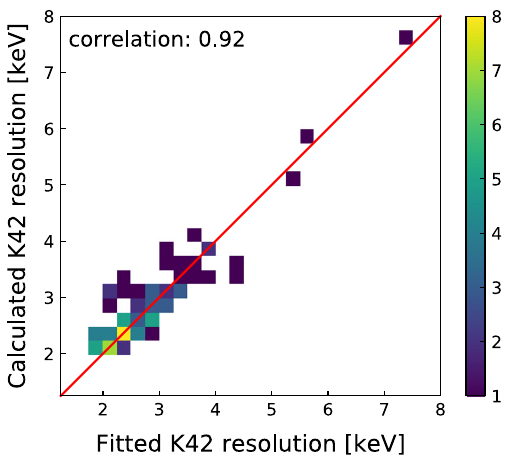
Fig. 7 Resolutionofthe1524.7keV 42 Klineasmeasuredfromphysics data and extracted from calibration data, for each detector partition. The red line shows the case of perfect